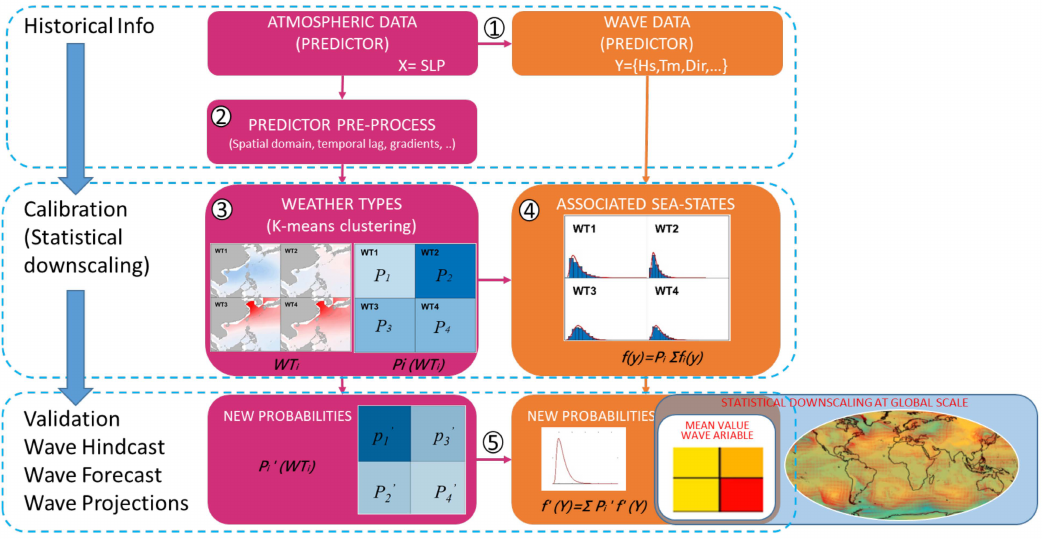
Figure 1. Framework of the statistical downscaling approach. To avoid observations with missing data, reanalysis data (ERA5) from numerical simulations are used. The correlation between the reanalysis data and the measured data is as high as 0.92 (Figure 2), so this data is considered to be quasi-real data.